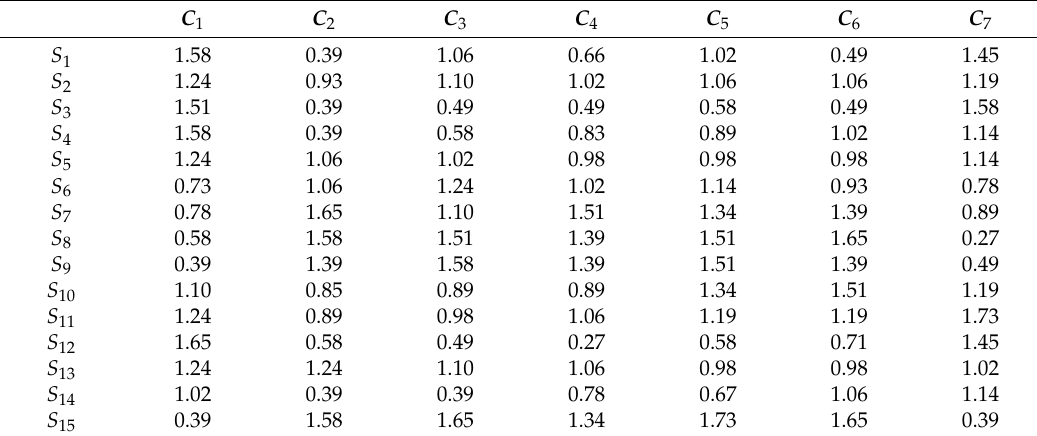
Table 12. The defuzzified decision-matrix for the comparative analysis.